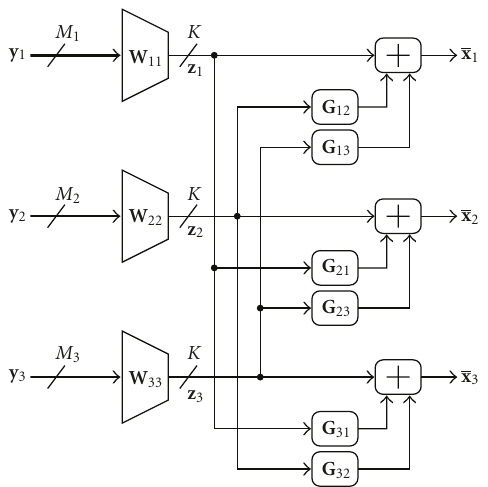
Figure 4: The DANSE K scheme with 3 nodes ( J = 3). Each node k estimates the desired signal x k using its own M k -channel microphone signal, and 2 K -channel signals broadcast by the other two